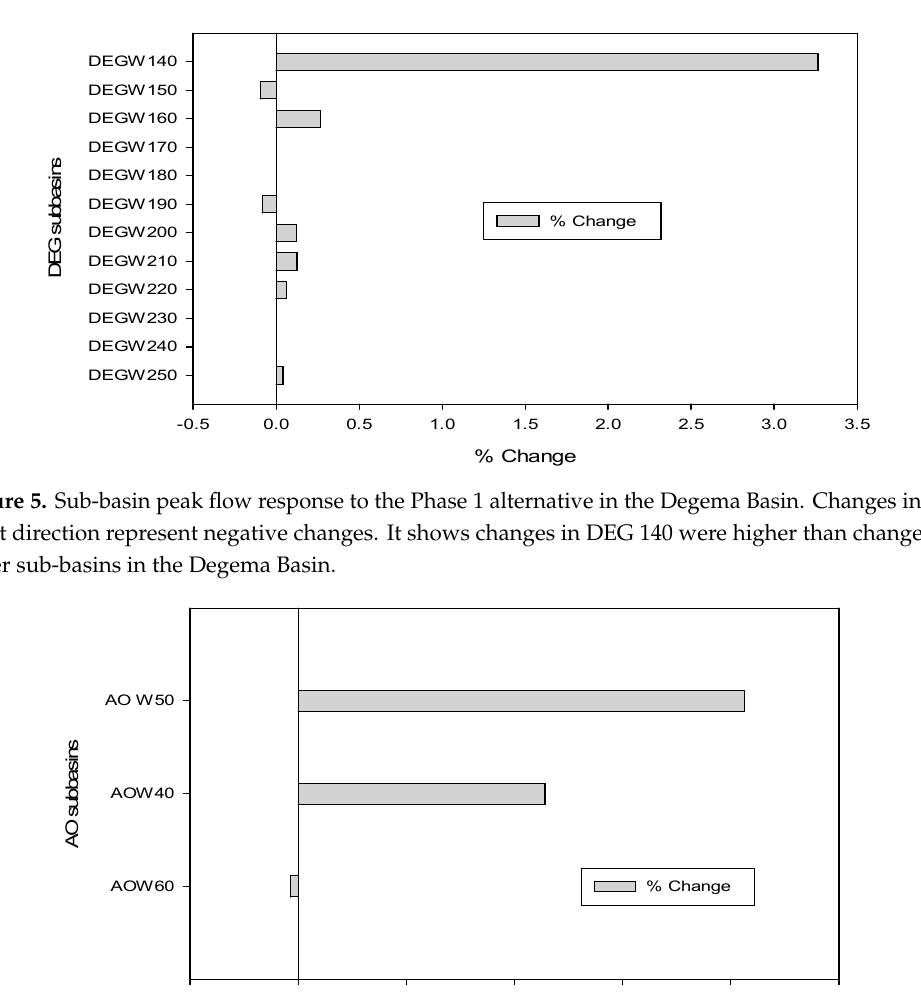
Figure 8. Sub-basin peak flow response to the Phase 1 alternative in the Buguma Basin. Changes in the right direction represent negative changes. It demonstrates that changes in peak flow due to the Buguma alternative was greater than changes in peak flow due to the 2003 conditions. In this basin, sub-basin BUG 140 experienced the highest peak flow. 5. Discussion Despite the scarcity of observed data in the region, the HEC-HMS model produced a reasonable performance when validated against the observed data. The results show how useful the hydrologic model is for assessing hydrologic responses and predicting future outcomes for the watershed. Validated results were found to be within the range when compared with related studies, e.g., Roy and Mistri [68] and Knebl , et al. [72]. Data scarcity remained a challenge in the study region. Based on the model performance, this study supports prior studies such as Sorrell [73] and Roy and Mistri [68] that the alternative PUB approach that rely on physically based and conceptual models are reliable for producing reasonable estimates of changes in peak flow in ungauged watersheds. However, this can be improved with the availability of observed (calibration) data. % Change -2